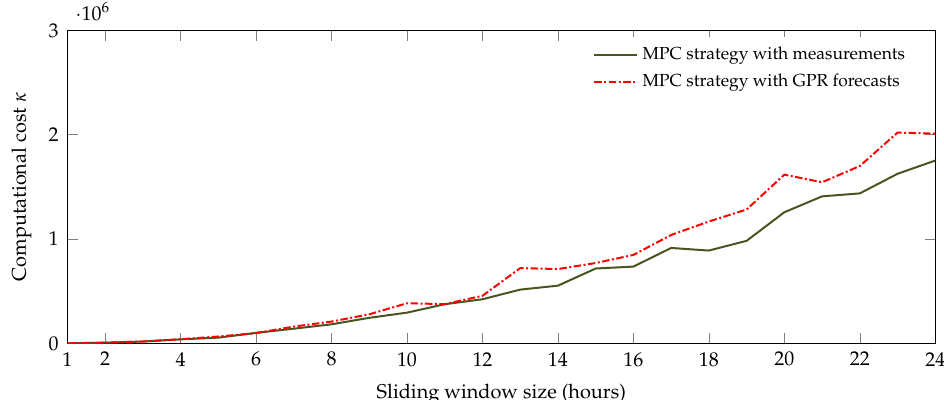
Figure 6. Computational complexity, measured as the mean number of function evaluations per sliding window weighted by its size.